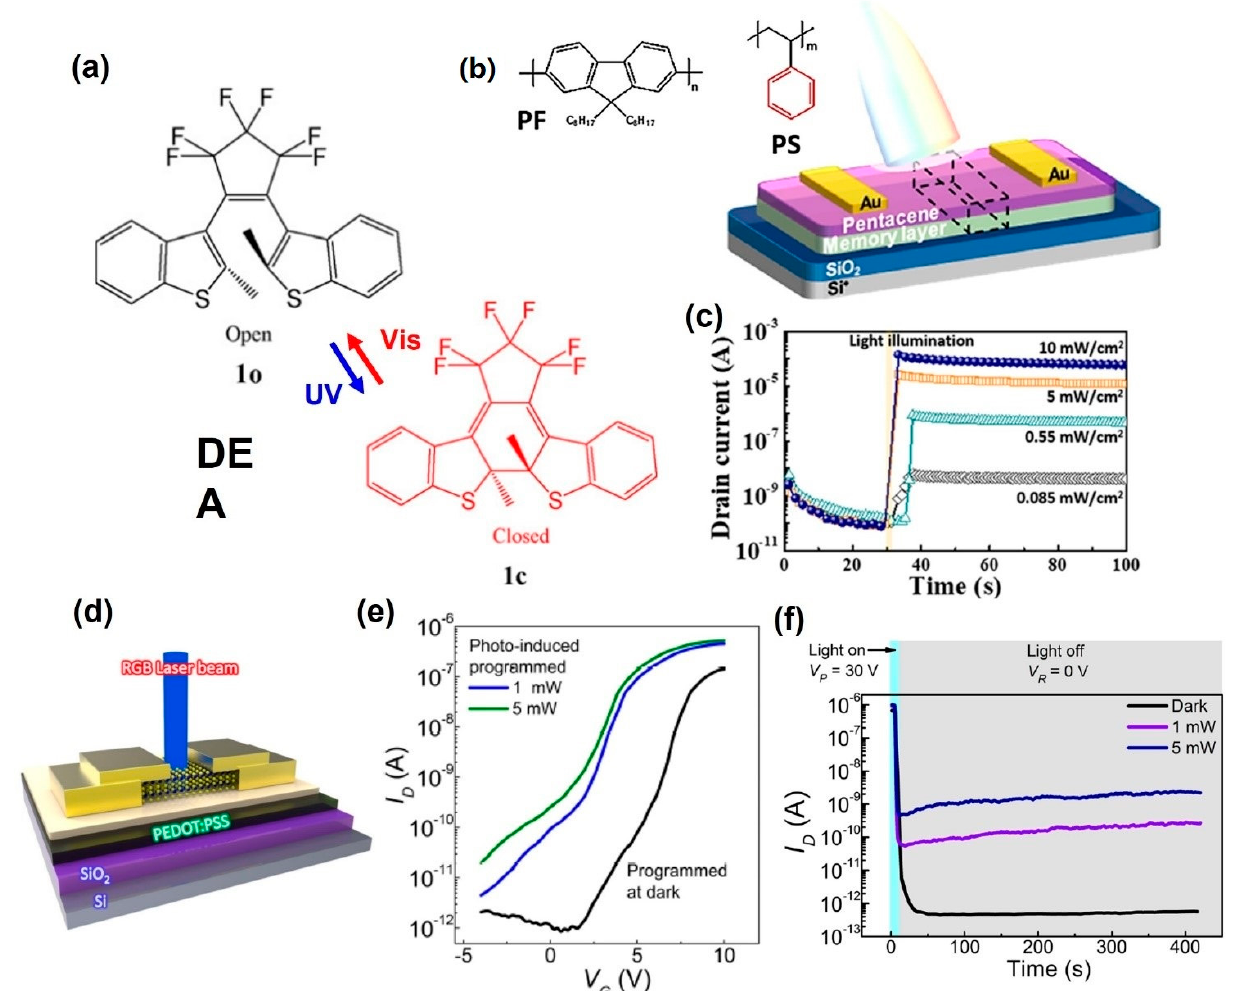
Figure 7. ( a ) Chemical formulae of the used DAE, in its open and closed form and structure of the devices (adapted from [104] with permission from Elsevier). ( b , c ) Multilevel photonic transistor memory using conjugated/insulated polymer blend electrets (adapted from [105] with permission from the American Chemical Society). ( d – f ) Schematic diagram of MoS 2 flash memory with a PEDOT:PSS floating gate under light illumination and transfer curves and retention curves depending on the programming operations (adapted from [106] with permission from